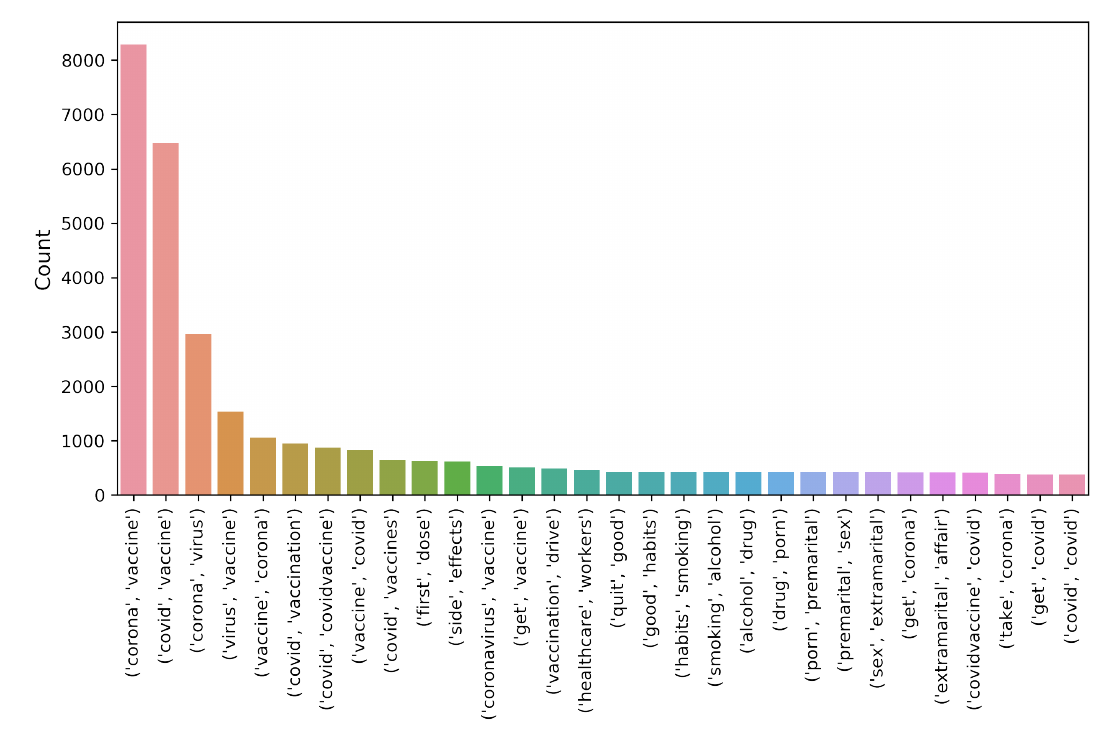
Figure 6. Chart for bi-gram terms from the collected dataset.